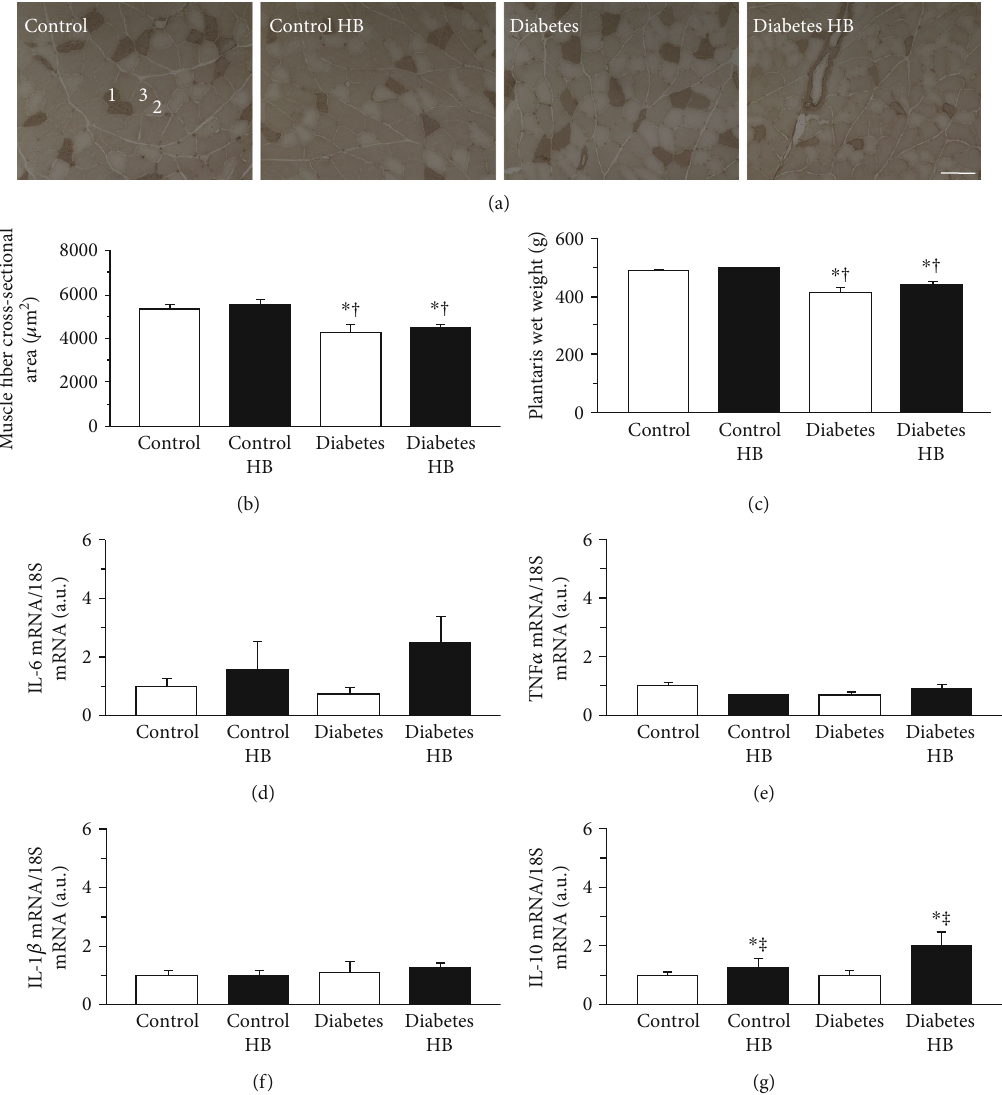
Figure 3: Muscle fi ber cross-sectional area, wet weight, and cytokine expression in the plantaris muscle. Representative sections of the plantaris muscle stained for ATPase activity (a), type IIB fi ber cross-sectional area (b), wet weight (c), expression levels of IL-6 mRNA (d), TNF α mRNA (e), IL-1 β mRNA (f), and IL-10 mRNA (g). Control: nontreated control group; Control HB: control treated with the hyperbaric normoxia group; Diabetes: nontreated diabetes group; Diabetes HB: diabetes treated with the hyperbaric normoxia group; 1: type I fi ber; 2: type IIA fi ber; 3: type IIB fi ber. Bar = 100 μ m . Values are means ± standard deviation . IL-6, TNF α , IL-1 β , and IL-10 mRNA expression levels were calculated as fold changes relative to the Control group. ∗ , † , ‡ Signi fi cantly di ff erent from the Control, Control HB, and Diabetes groups, p < 0 : 05 ,